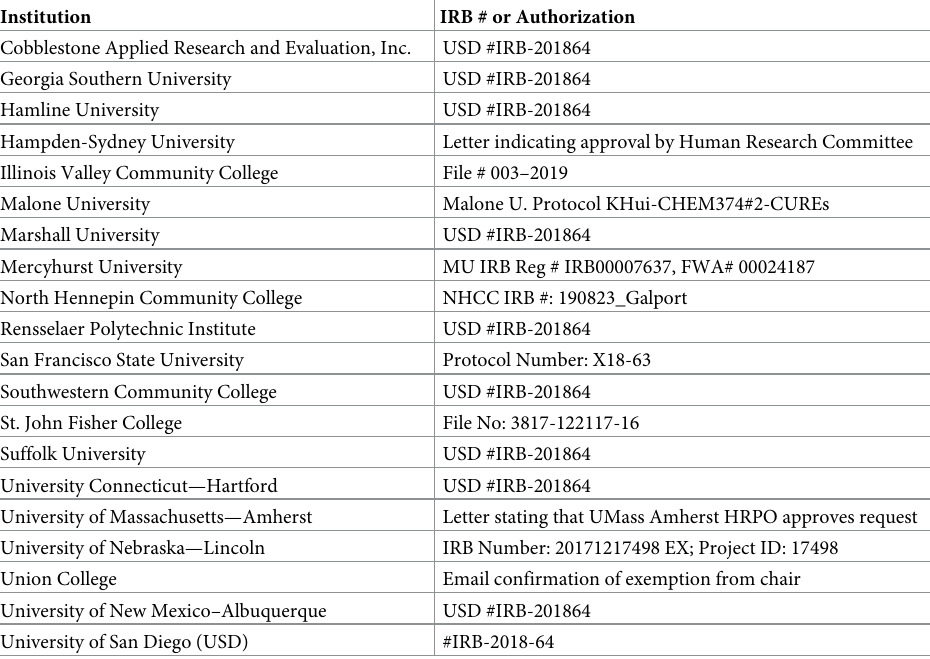
Table 2. IRB agreement numbers and authorizing institutions.